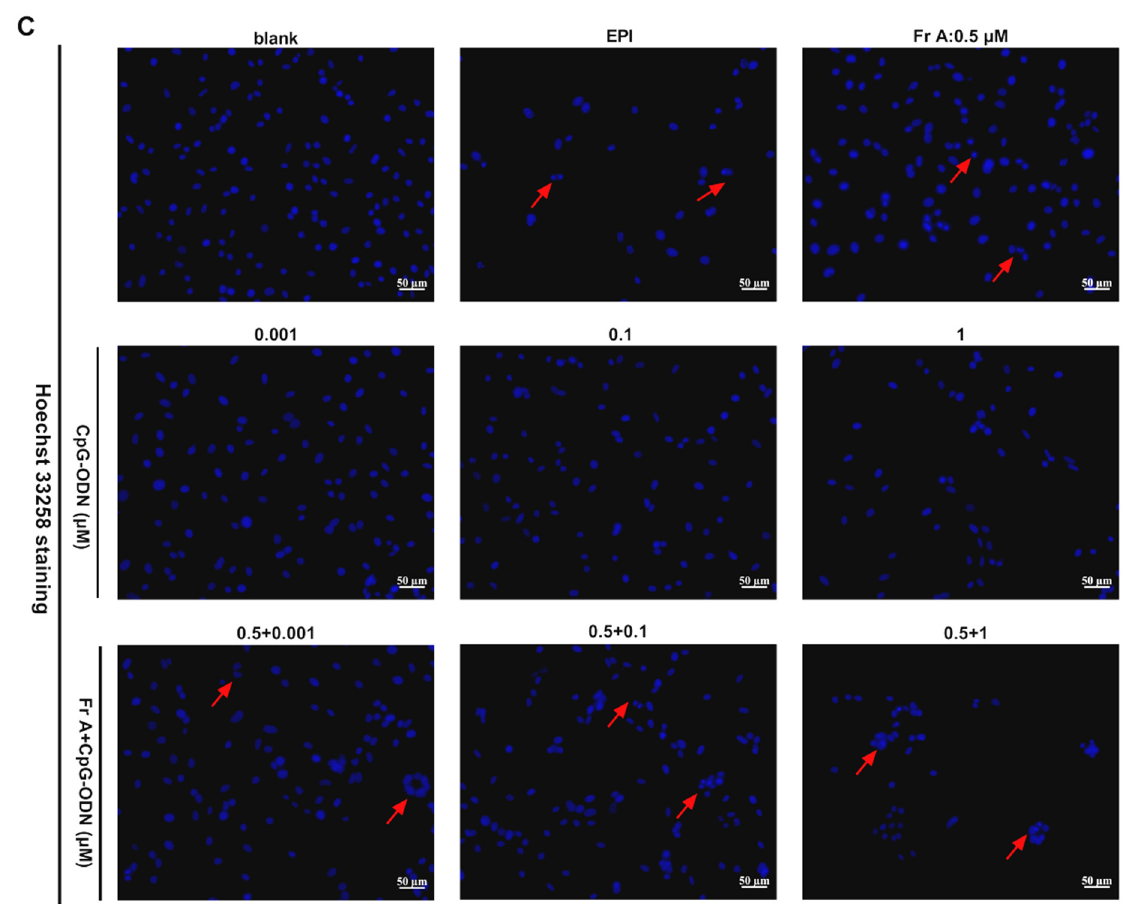
Figure 5. Effects of Frondoside A (Fr A) and CpG-ODN on cell cycle, apoptosis and nuclei morphology in bladder cancer cells. Cells were treated with Frondoside A (0.5 µ M) and different concentrations of CpG-ODN (0.001, 0.1, and 1 µ M) individually and in combination for 48 h. The distribution of cell cycle ( A ). The induction of cell apoptosis ( B ) and the morphological changes (The pictures were made at × 200) ( C ). Data represent the mean ± S.E.M. * Significantly different at p < 0.05. ** Significantly different at p < 0.01. *** Significantly different at p < 0.001.